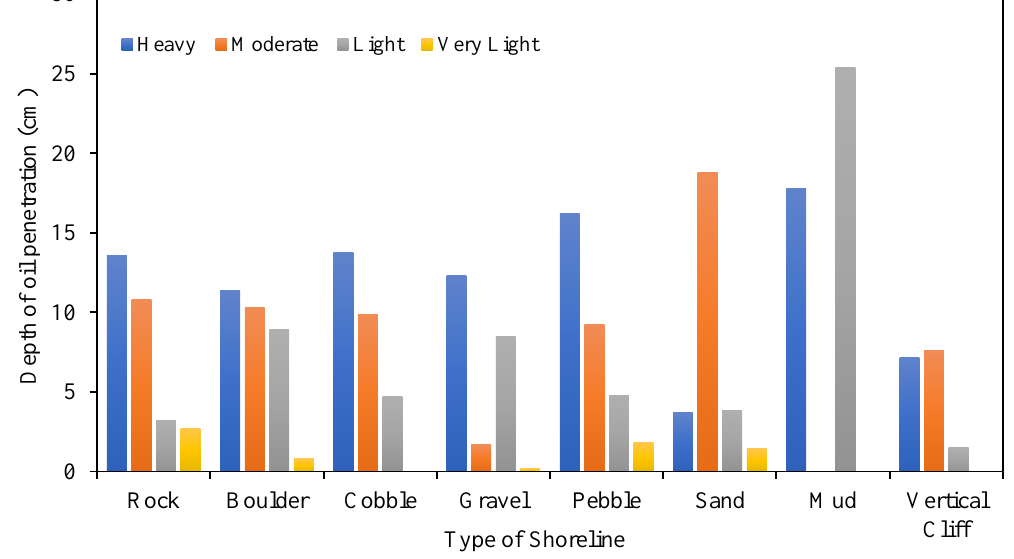
Figure 3. Depth of oil penetration by shoreline sediment type based on various oiling degrees considering Exxon Valdez Spill database.